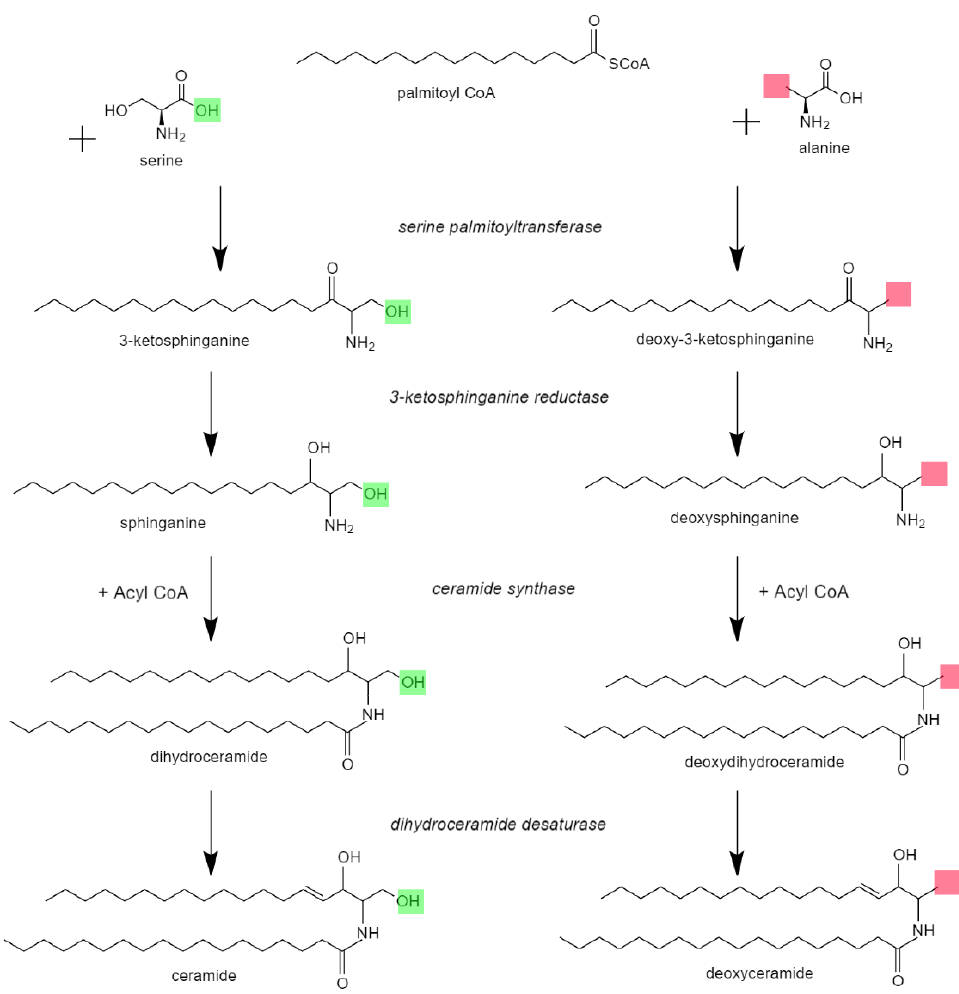
Figure 1. De novo sphingolipid biosynthesis pathway. The serine palmitoyltransferase (SPT) complex incorporates serine into palmitoyl-CoA as the first and rate-limiting step of sphingolipid biosynthesis. Alternatively, alanine (or glycine) can be incorporated in certain settings to produce deoxysphingolipids and deoxyceramides. If glycine is incorporated (not shown), deoxymethylsphingolipids are generated. The difference in products when incorporating alanine (or glycine) instead of serine is the lack of a hydroxyl group, highlighted in green where present and in red where absent.